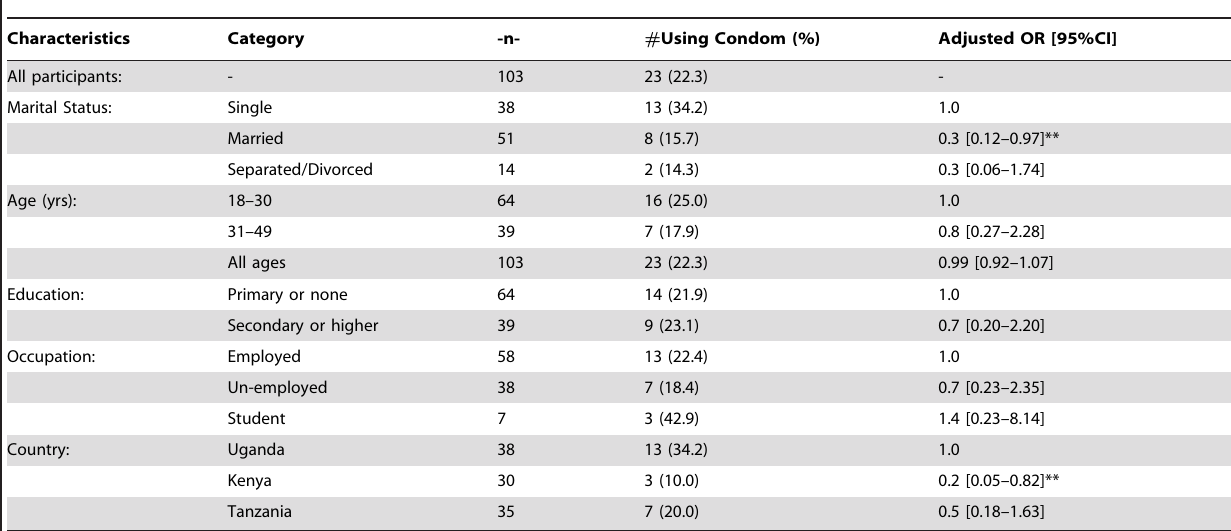
Table 5. Previous Condom Use as Contraception by Participant Characteristics*